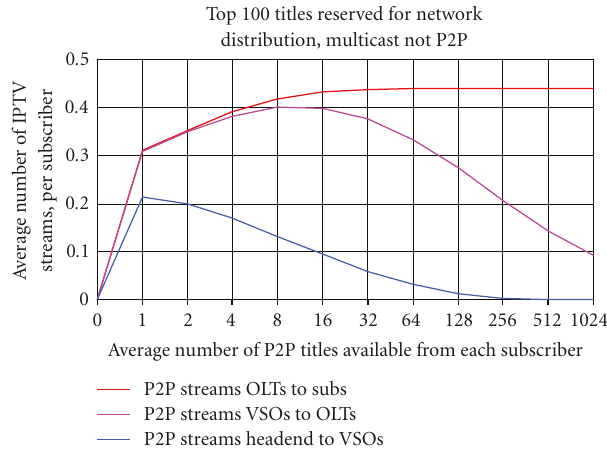
Figure 5: P2P network tra ffi c at various network aggregation